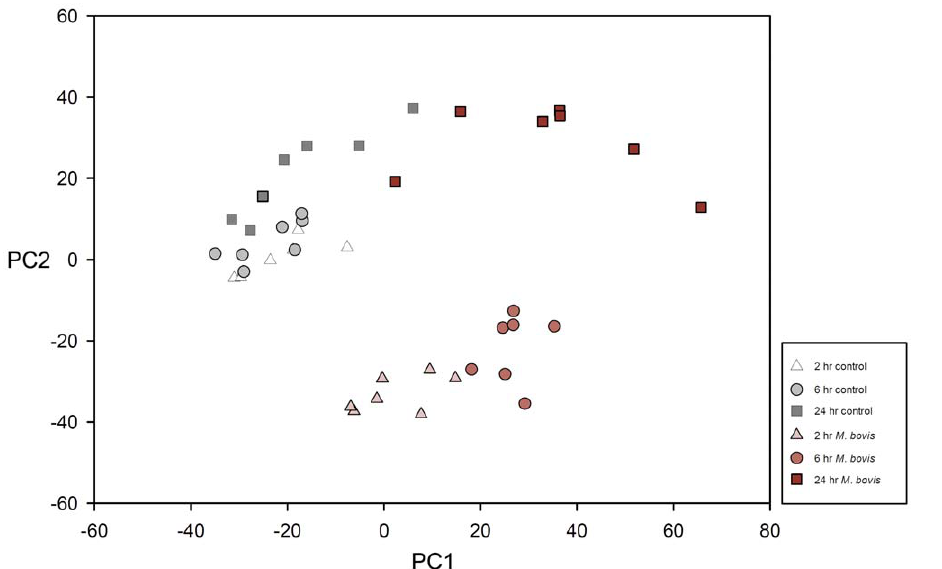
Figure 2. Principal component analysis for all individual control and M.bovis -challenged MDM at the 2 hour, 6 hour and 24 hour time points. Principal component (PC) 1 and PC2 are shown (accounting for 23.31% and 17.05% of the total variation, respectively). PCA was performed using data for all genes whose probes passed the data filtering process with Euclidean distance as the distance metric.